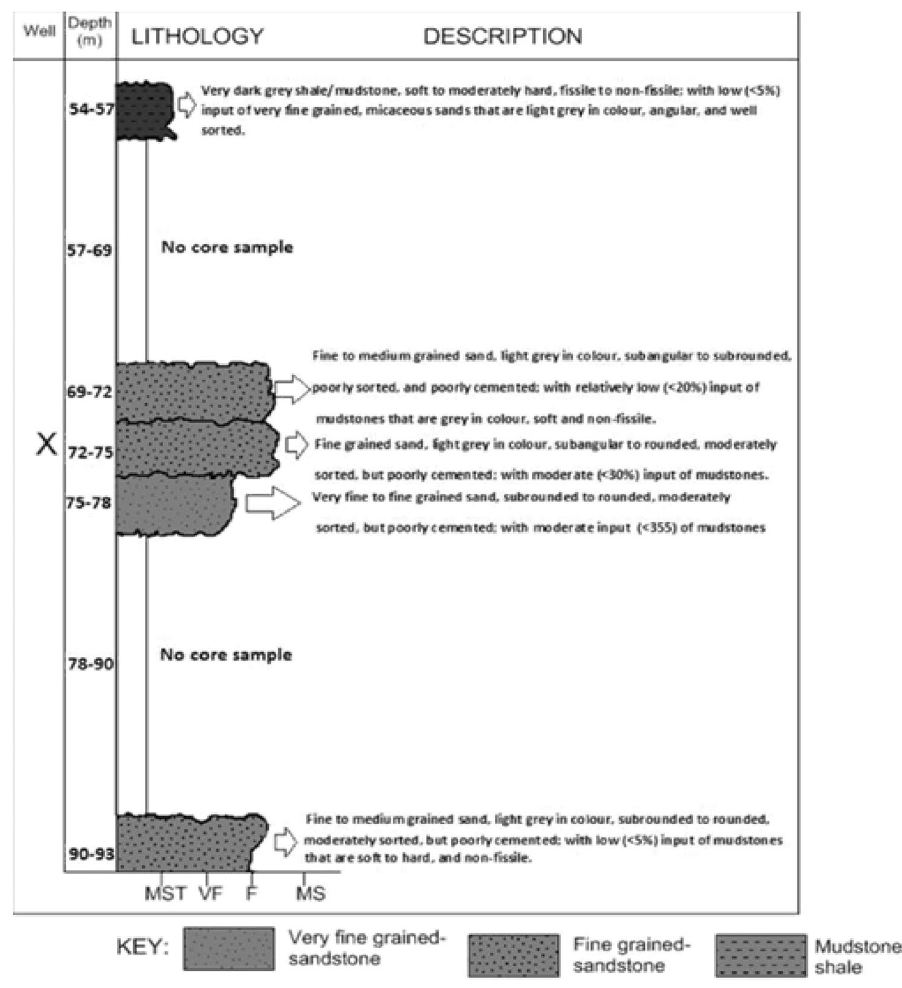
Fig. 3 Litho-section of core samples at Ayede-Ajegunle (Well